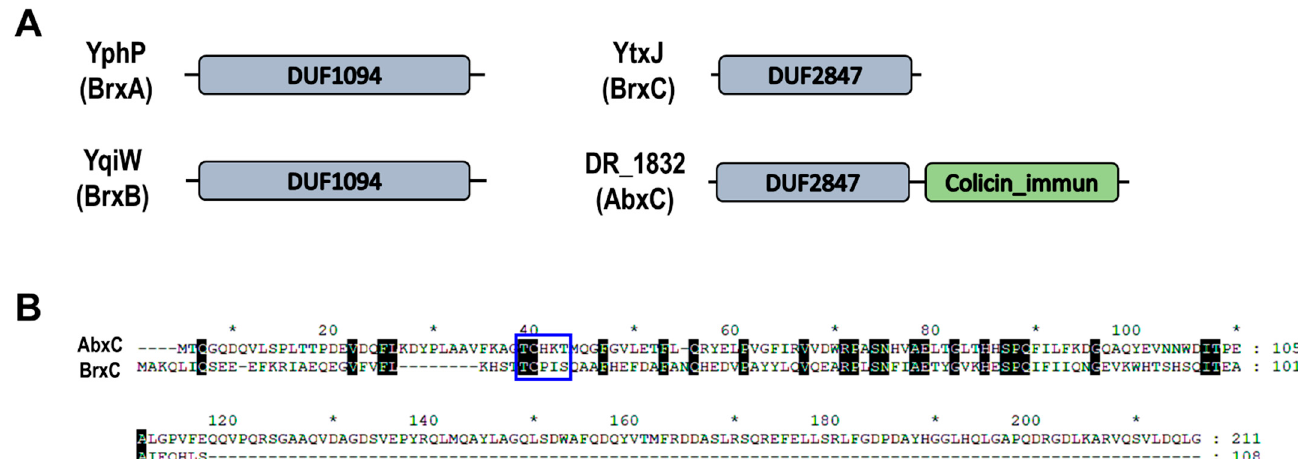
Figure 1. Comparison of bacilliredoxin (Brx) proteins from Bacillus subtilis and DR_1832 from Deinococcus radiodurans . ( A ) Schematic comparison of the domain structures of Brxs and atypical BrxC (AbxC). The C-terminal extended region (colicin_immun) of DR_1832 (atypical BrxC; AbxC) has similarity with bacterial self-protective colicin-like immunity domain (PF09204). ( B ) Comparison of amino acid sequences of AbxC and B. subtilis BrxC. Alignment was performed using Clustal Omega, and protein sequences were retrieved from the Uniprot database (www.uniprot.org. Accessed 8 June 2021): Q9RTD3_DEIRA (DR_1832) and YtxJ_BACSU (BrxC). White letters on black shading represent 100% identity. The blue line box indicates the TCHKT and TCPIS motif conserved in AbxC and BrxC, respectively.